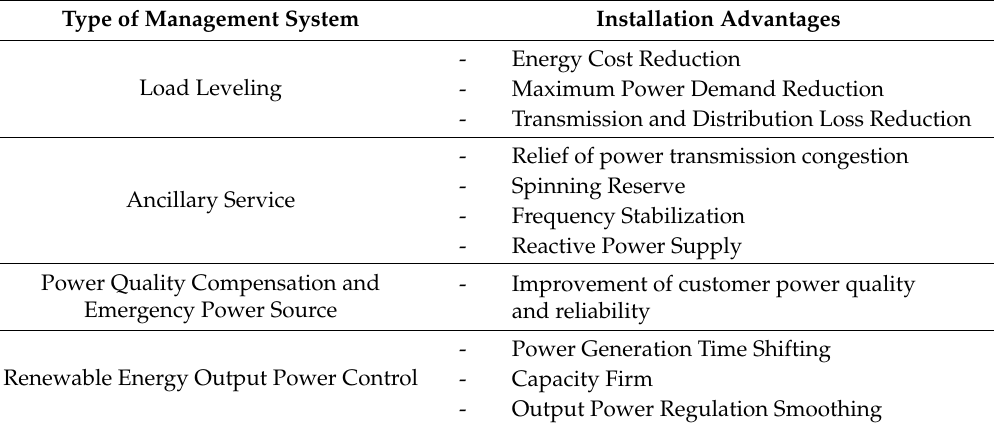
Table 3. Management Systems and Installation Advantages of BESS.